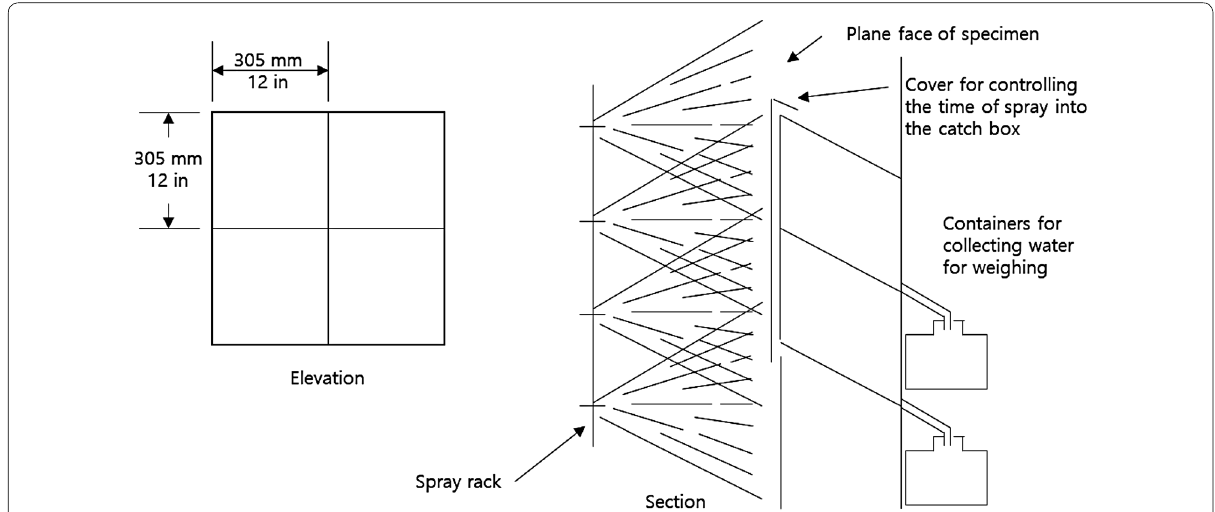
Fig. 8 Catch box for calibrating water-spray